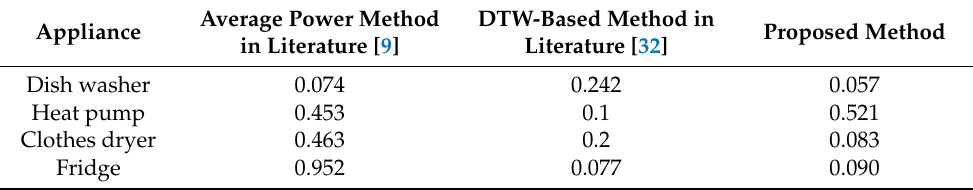
Table 6. PCE (%) values compared with the method in References [9] and [32].